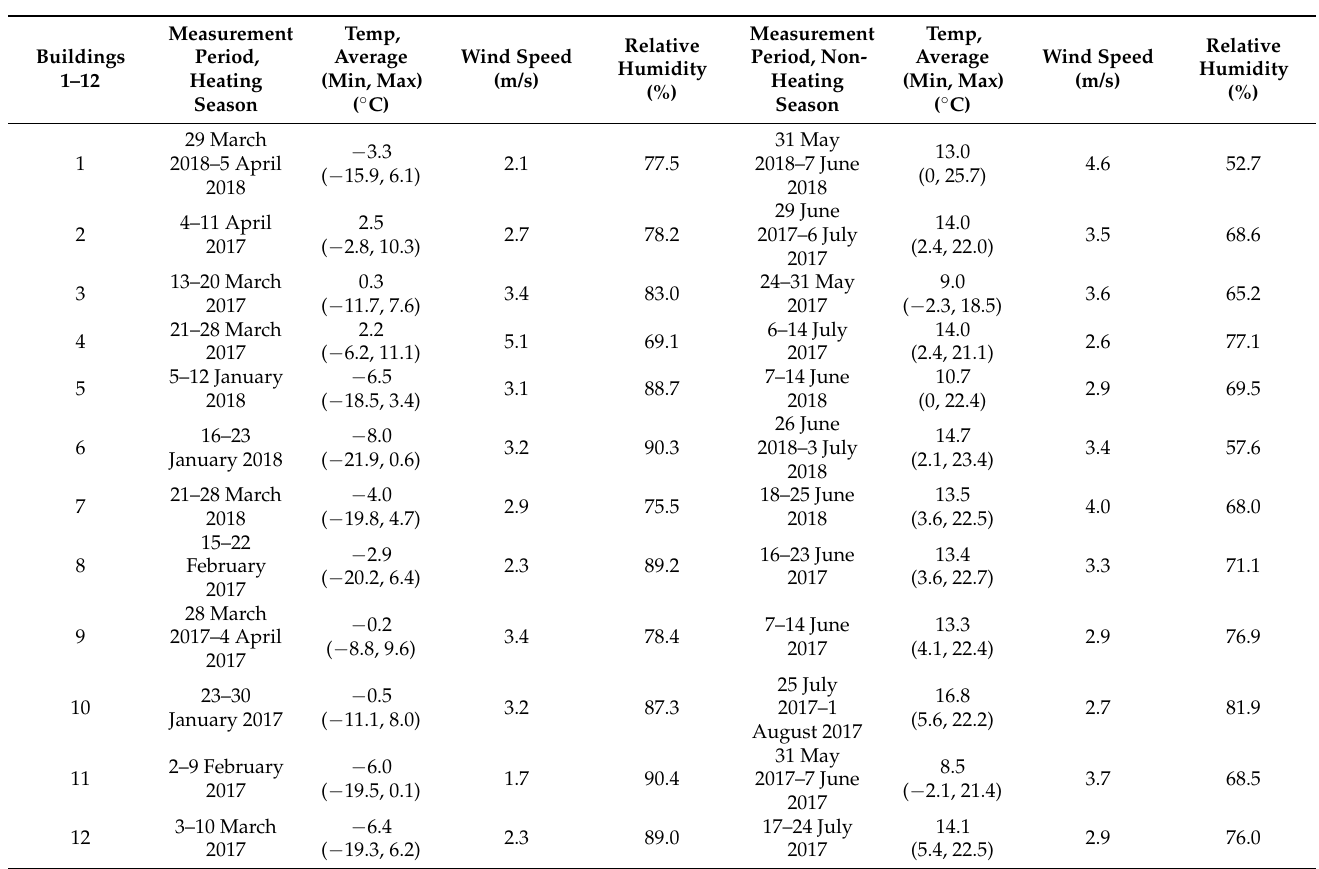
Table A1. Meteorological characteristics at Umea meteorological station during the measurement periods in the heating and the non-heating